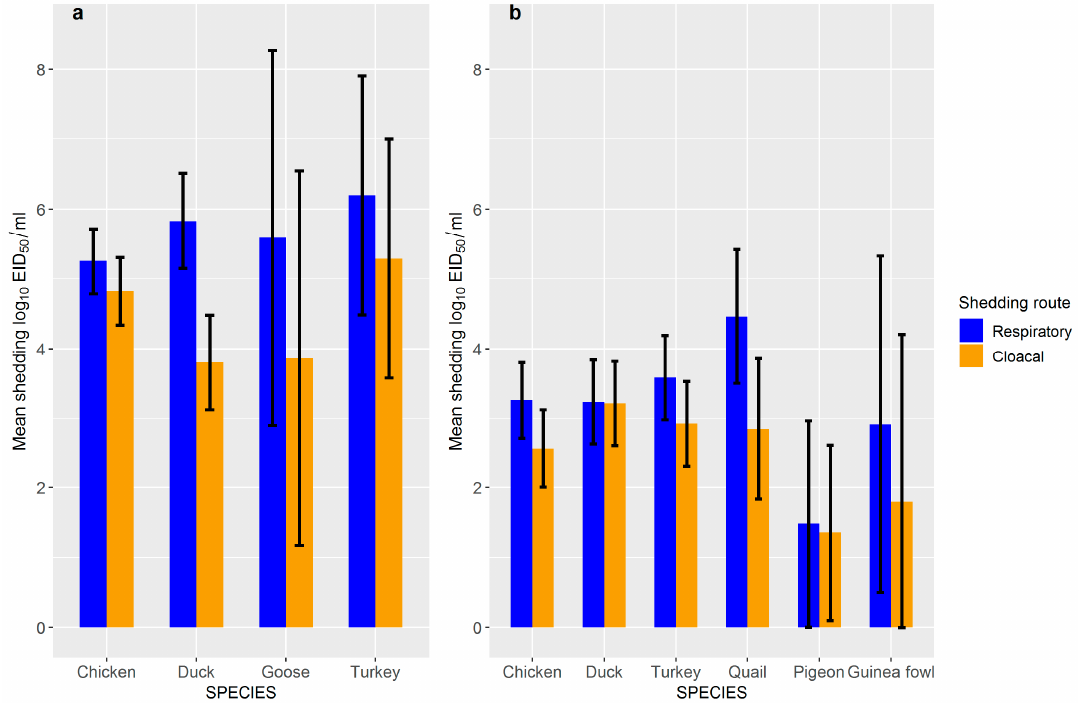
Figure 4. Mean shedding (log 10 EID 50 / mL) in respiratory and cloacal swabs of ( a ) highly pathogenic avian influenza virus (HPAIV) and ( b ) low pathogenic AIV (LPAIV) in chicken, duck, goose, turkey, quail, pigeon and guinea fowl after correcting for the effect of virus subtype, inoculation route, dose, virus origin, etc. Error bars represent 95% confidence intervals for the mean estimates.